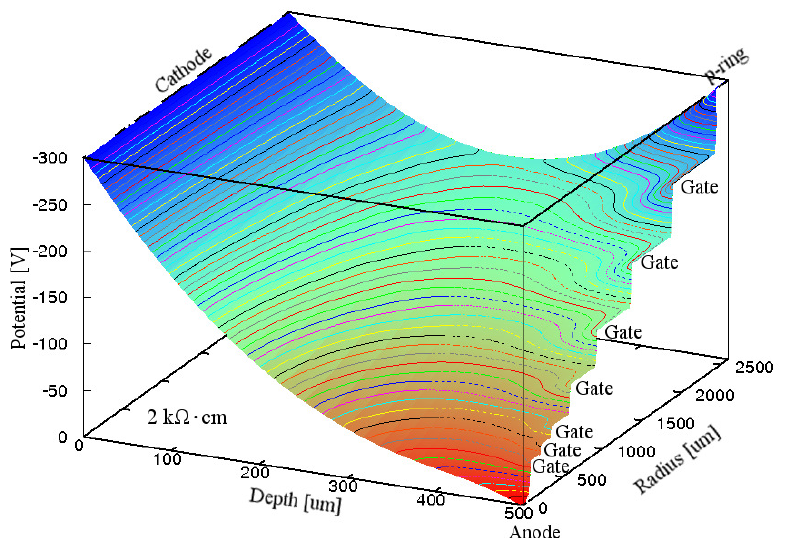
Figure 4. Simulated electric potential distribution in the Si substrate inside the p-ring of a 0 . 5 -mm-thick GSDD with R of 3 . 5 mm and ρ of 2 k Ω · cm for Gate A. A reverse bias chip Si voltage of − 300 V was applied to the cathode, p-ring and seven gates. Equipotential lines are shown at 5 V intervals.